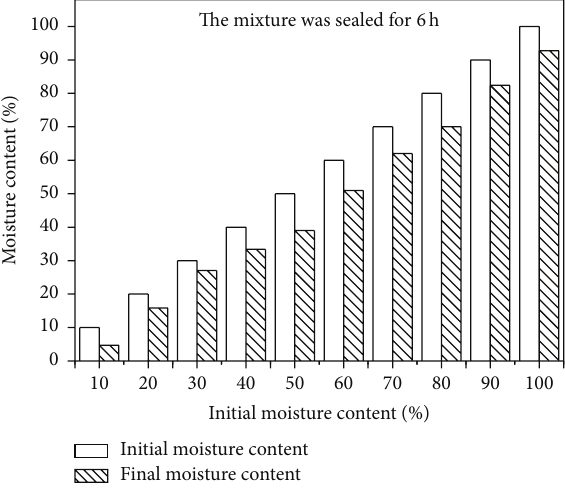
Figure 3: Moisture content before and after preliminary test